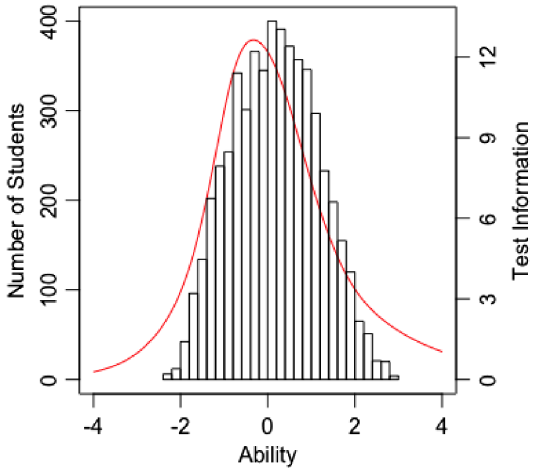
FIG. 9. Plotted in the CSEM scale, the histogram of estimated student abilities for the BEMA is overlaid with the BEMA ’ s test information curve. This shows that the bulk of the students are located in a region of ability space where their latent abilities will be well estimated.